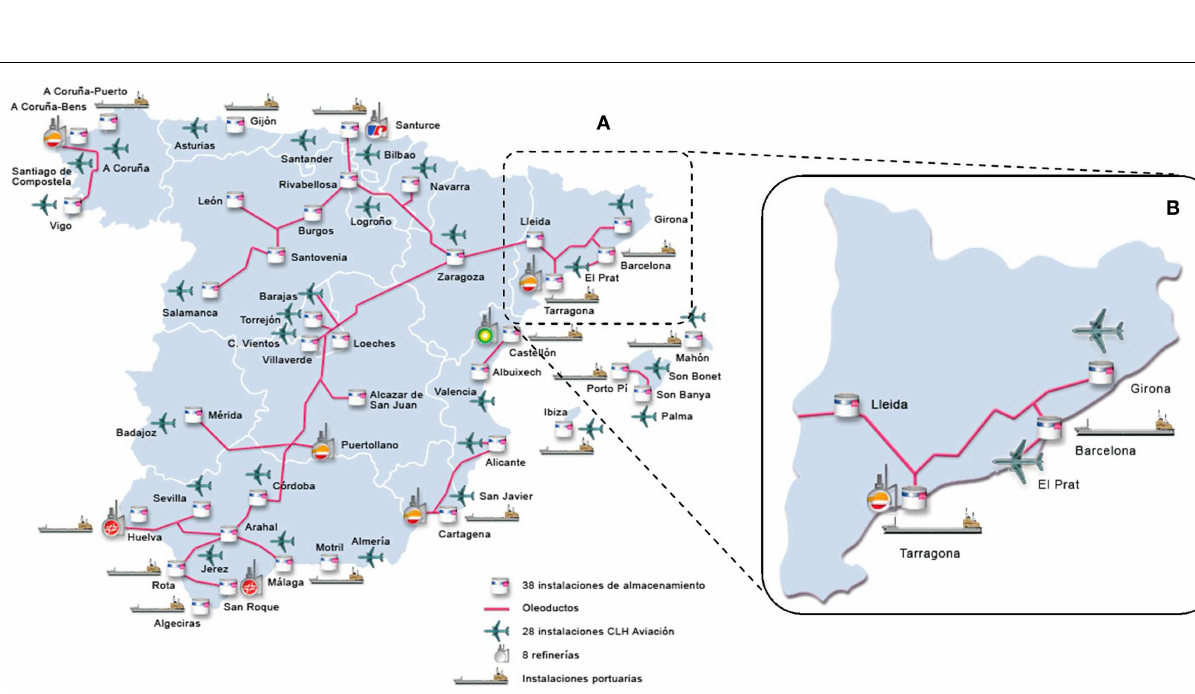
FIGURE 2 |The Catalan energy system in 2009 .Values in terajoules. Adapted from Generalitat de Catalunya (2012).